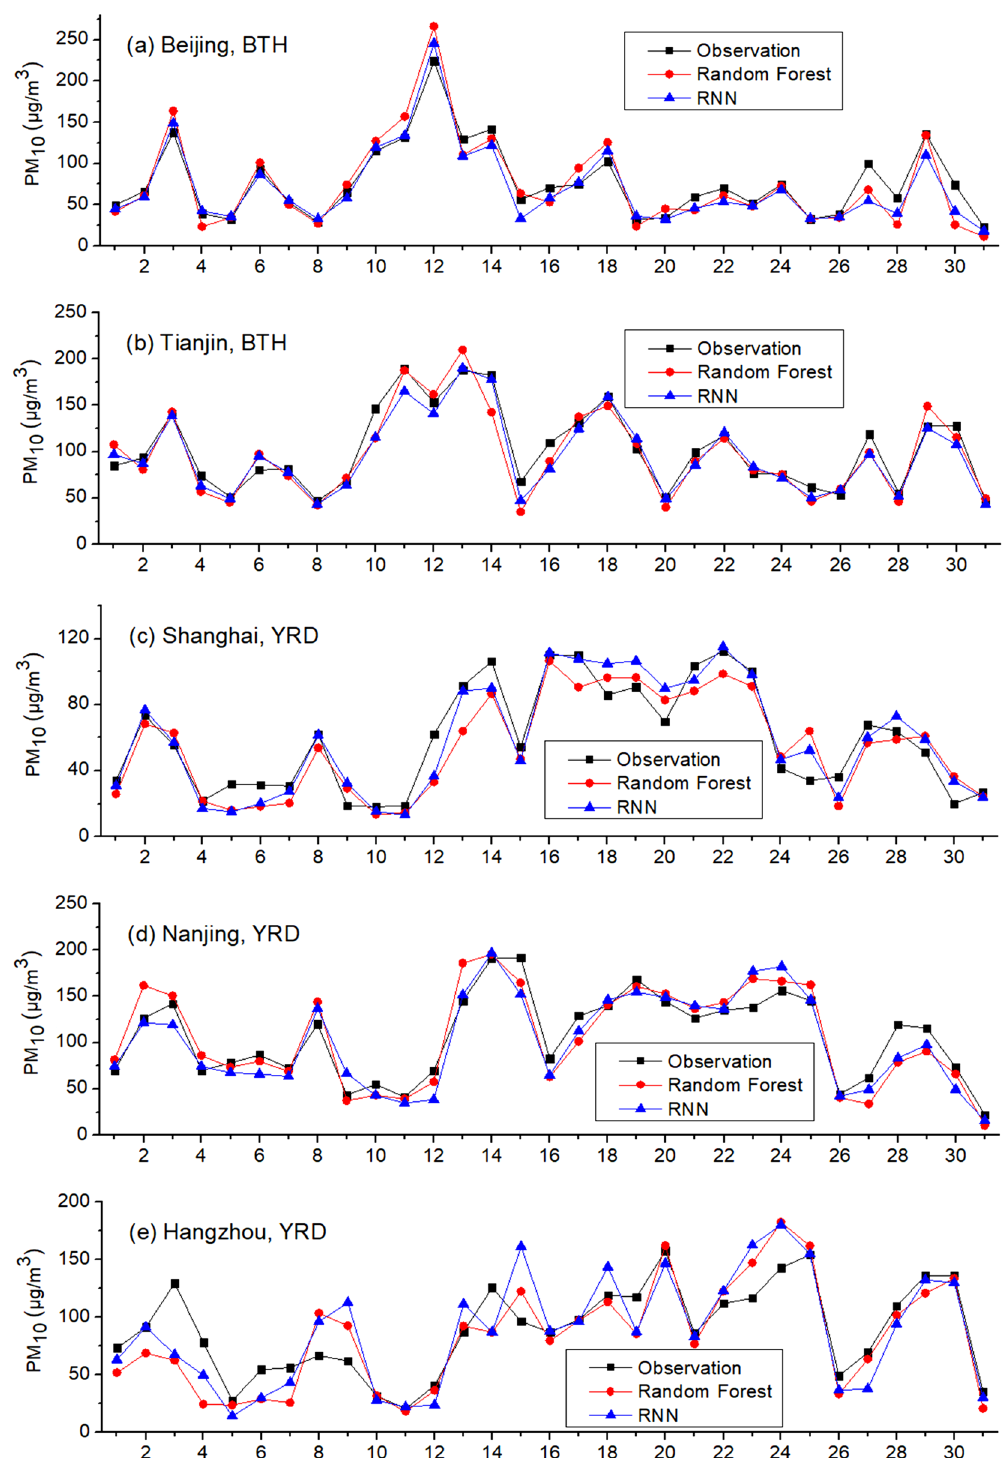
Figure 3. Observed and simulated PM 10 in January 2019: Scenario